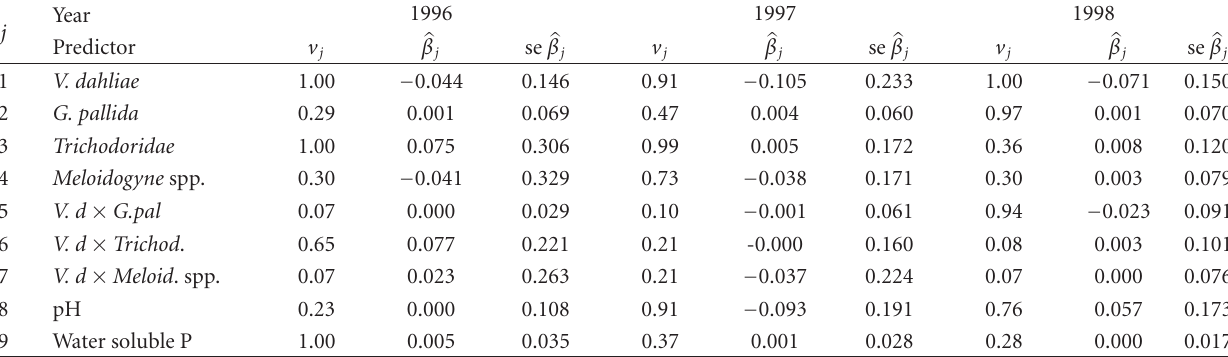
Table 5: Summed weights, v j = Σ wrI j ( r ), weighted regression coe ffi cients, (cid:10) β dry yield in the years 1996, 1997, and